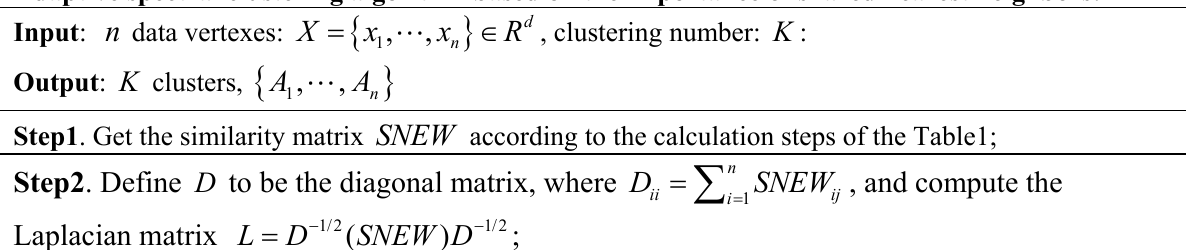
Table2. Adaptive spectral clustering algorithm based on the importance of shared nearest neighbors.